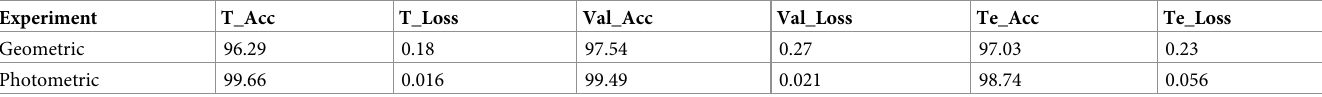
Table 16. Comparison of performance between geometric and photometric augmented dataset.